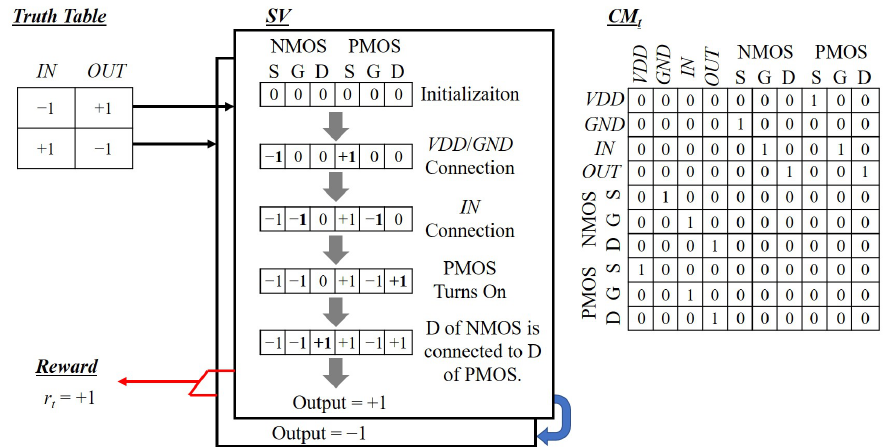
Figure 7. Verification steps for an inverter. Since outputs for all inputs ( IN ) are matched to target outputs ( OUT ), r t is decided as